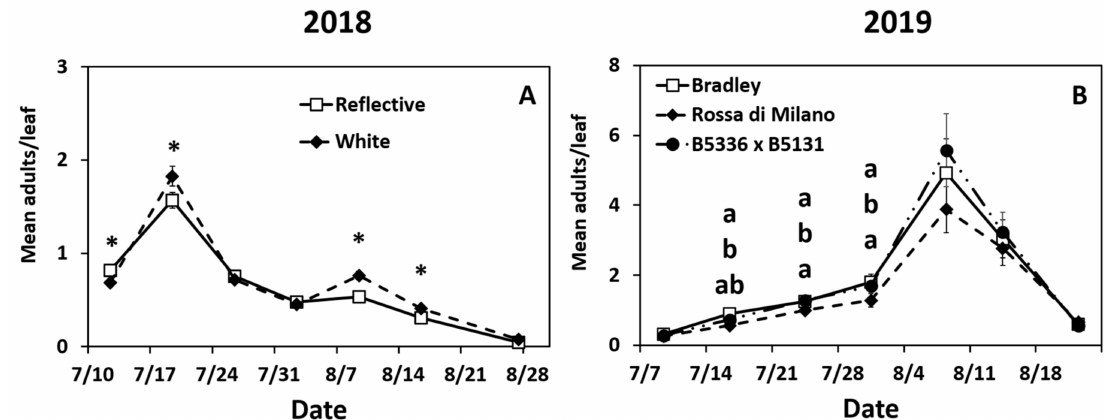
Figure 1. Significant effects of highest order interactions on mean ( ± SE) adult thrips densities per leaf. Significant effects include the interactions of date × mulch type ( A ) and date × cultivar ( B ) biopesticide in 2018 ( A ) and 2019 ( B ). Thrips were counted weekly for seven weeks. The standard errors at some time points are small and may appear behind the point marker. Means with asterisks (*) or different letters are significantly different at α = 0.05 using Tukey’s LSD post hoc test. Letters are listed from top to bottom in the order of treatments in the legend.